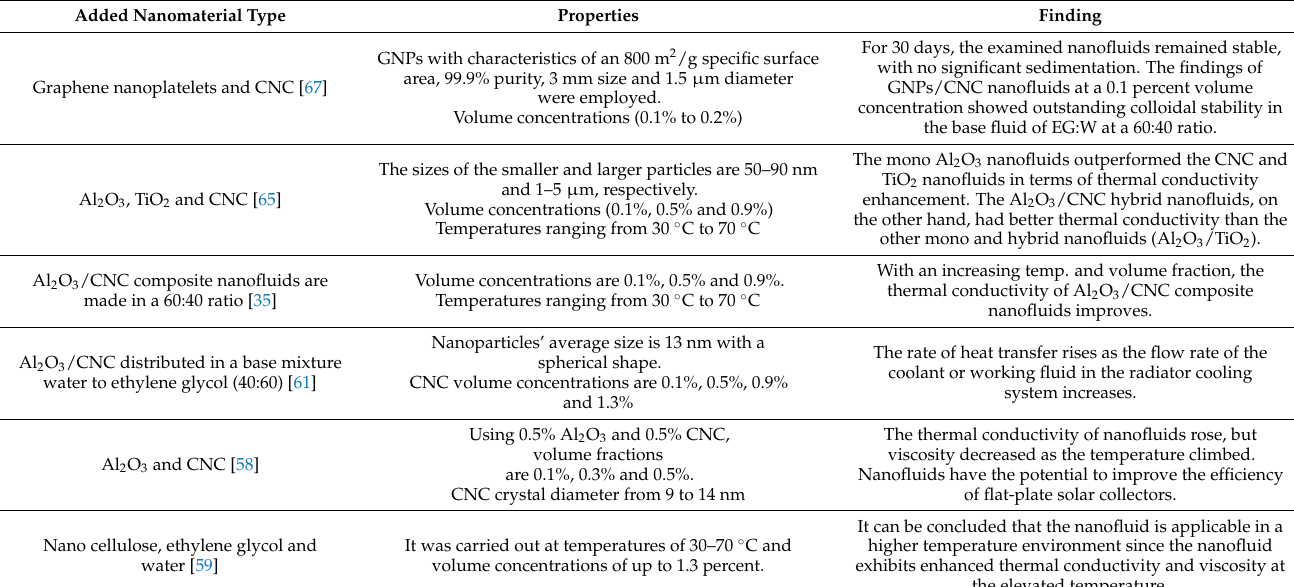
Table 5. Nanocellulose in combination with other